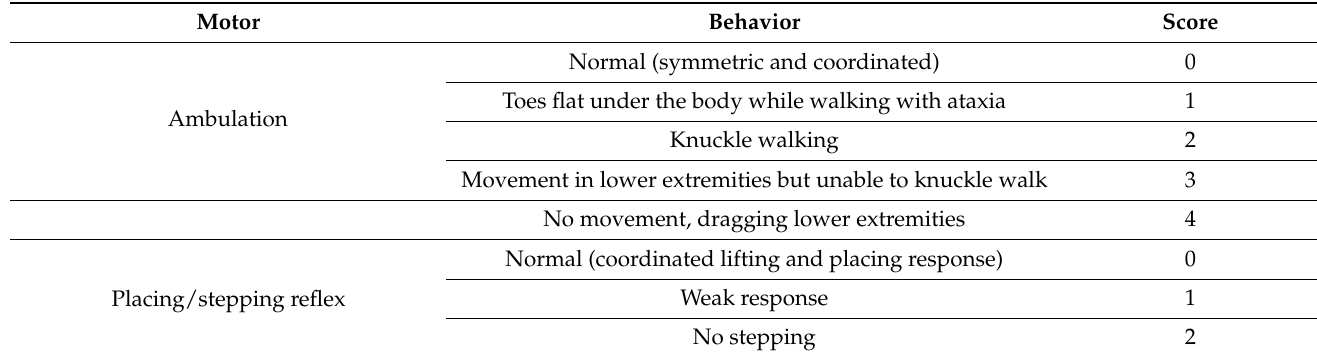
Table 1. Motor function